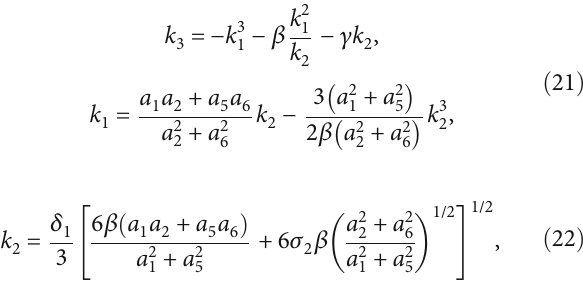
Figure 5: The corresponding contour plots of the mixed solution equation (23) with a = − σ = 1 , and a = a = 0 : (a) t = − 100 ; (b) t = − 25 ; (c) t = 0 ; (d) t = 25 ; (e) t = 100 σ 1 2 4 8